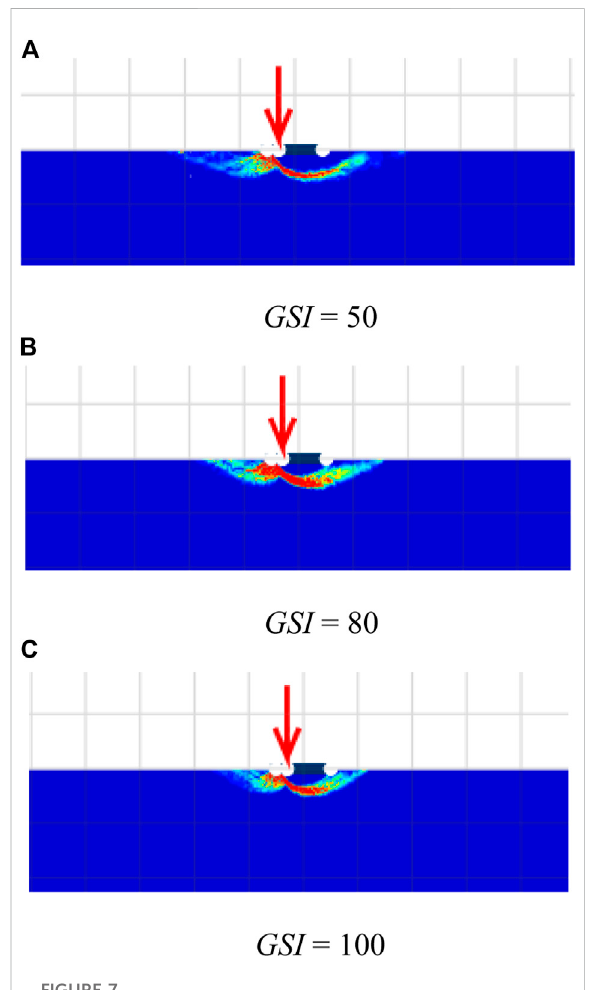
FIGURE 7 Shear dissipations for various GSI with β = 90 ° , α = 1, m i = 5, γ B/ σ ci = 0, and e/B = 0.3. (A) GSI = 50 (B) GSI = 80 (C) GSI = 100.